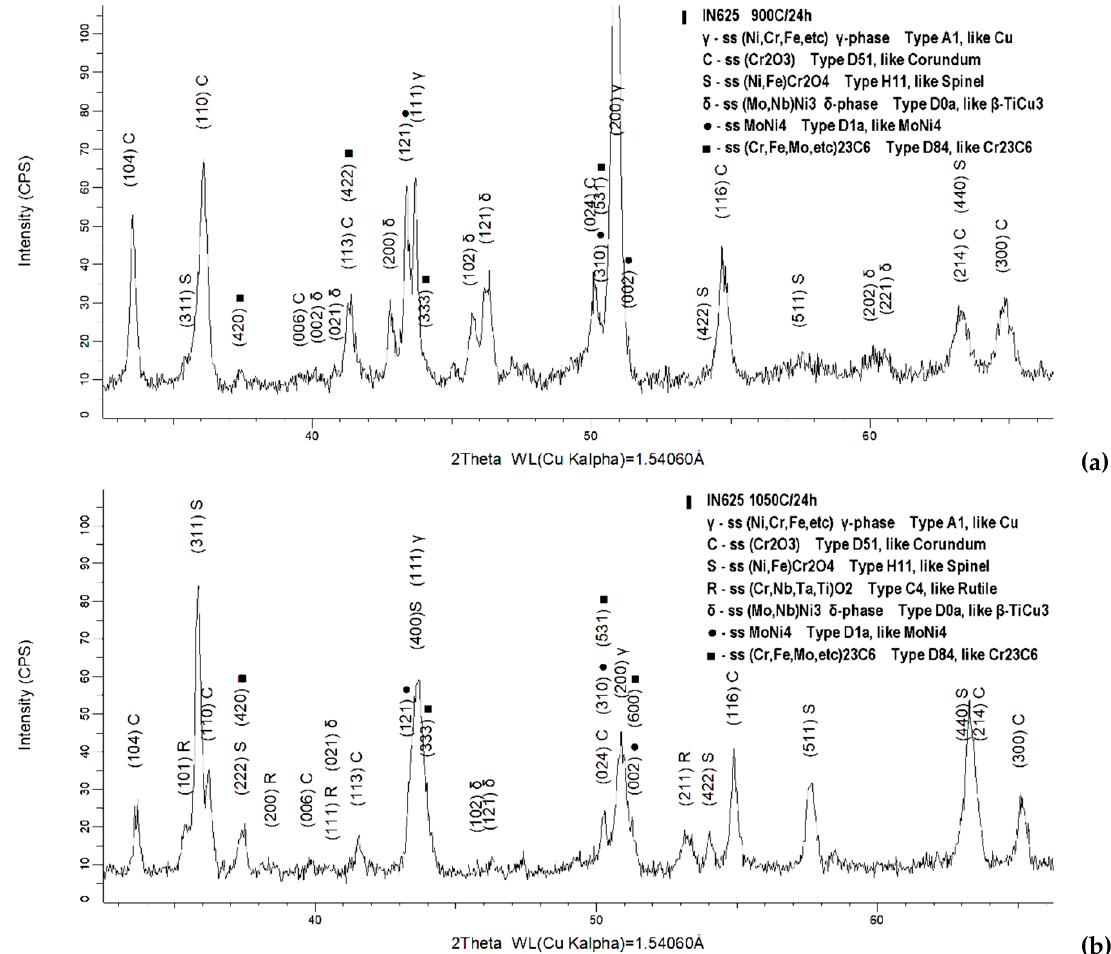
ff raction patterns of the specimens oxidized for 24 h at 900 ◦ C ( a ) and 1050 ◦ C ( b Figure 6. Diffraction patterns of the specimens oxidized for 24 h at 900 °C ( a ) and 1050 °C ( b ). Figure 6. Di